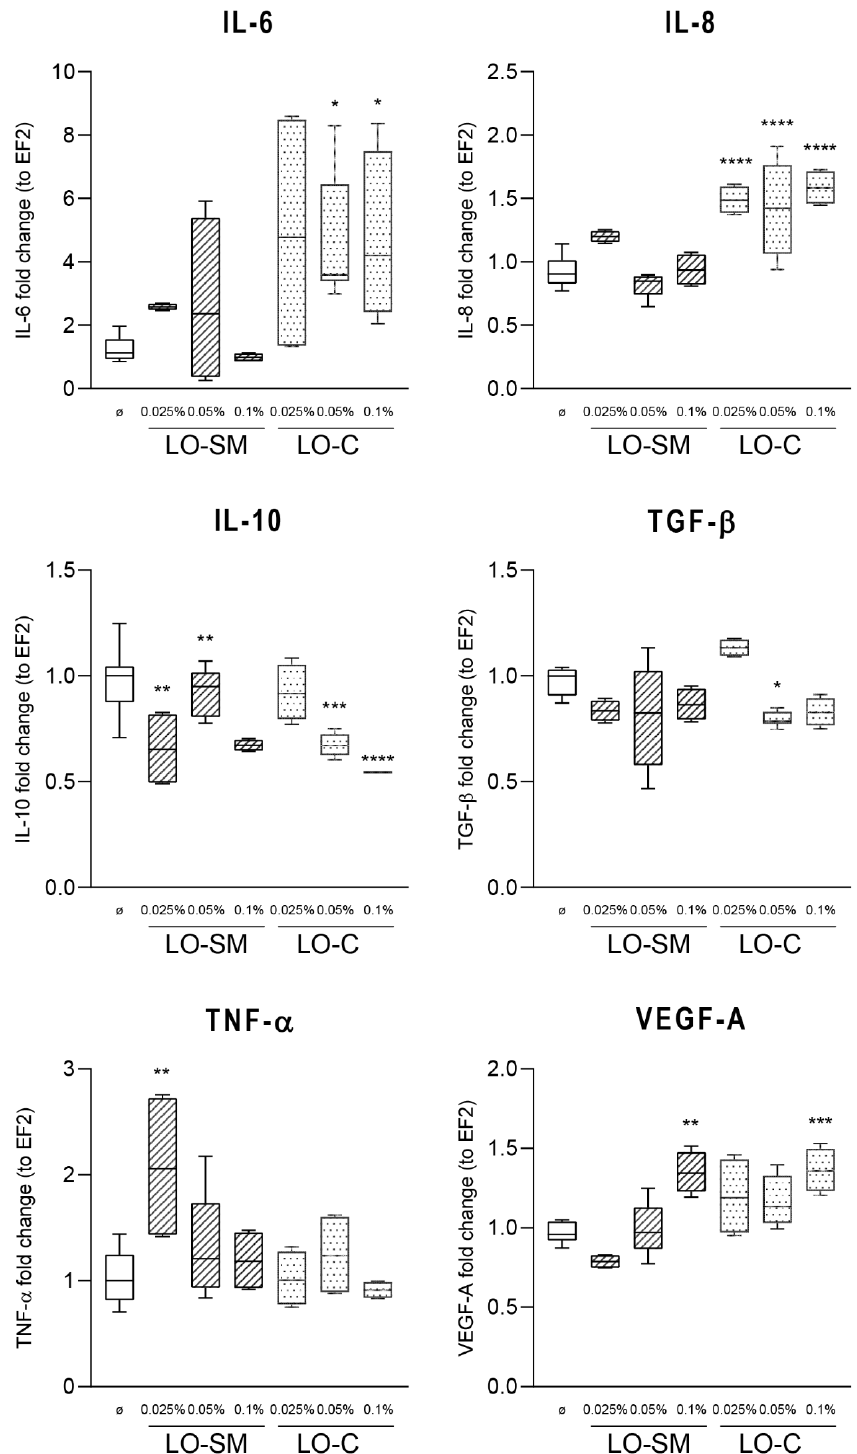
Figure 5. Effect of lavender oil stimulation on the expression level of cytokines in human macrophages. hMDM cells were stimulated with designated concentrations ( v / v ) of commercial or in-house preparation of lavender oil for 4 h. Level of mRNA production of cytokines: IL-6, IL-8, IL-10, TGF- β , TNF- α , and VEGFA were verified with RT-PCR. Values are mean with range. Groups were compared to the control, and statistical analysis was performed using GraphPad Prism and build-in ANOVA test. p -values ≤ 0.05 were considered significant. *— p = 0.05–0.011; **— p ≤ 0.01; ***— p ≤ 0.001; ****— p ≤